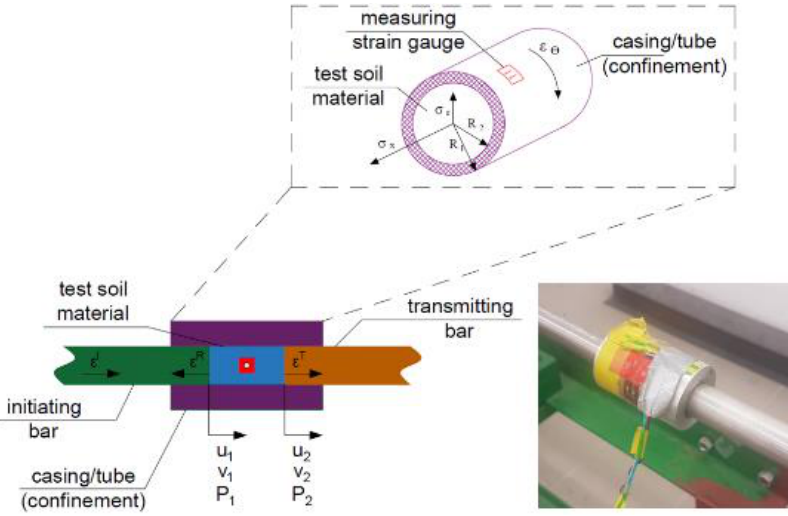
Figure 4. Cylindrical soil specimen in casing/tube (reprinted from Ref. [71]).